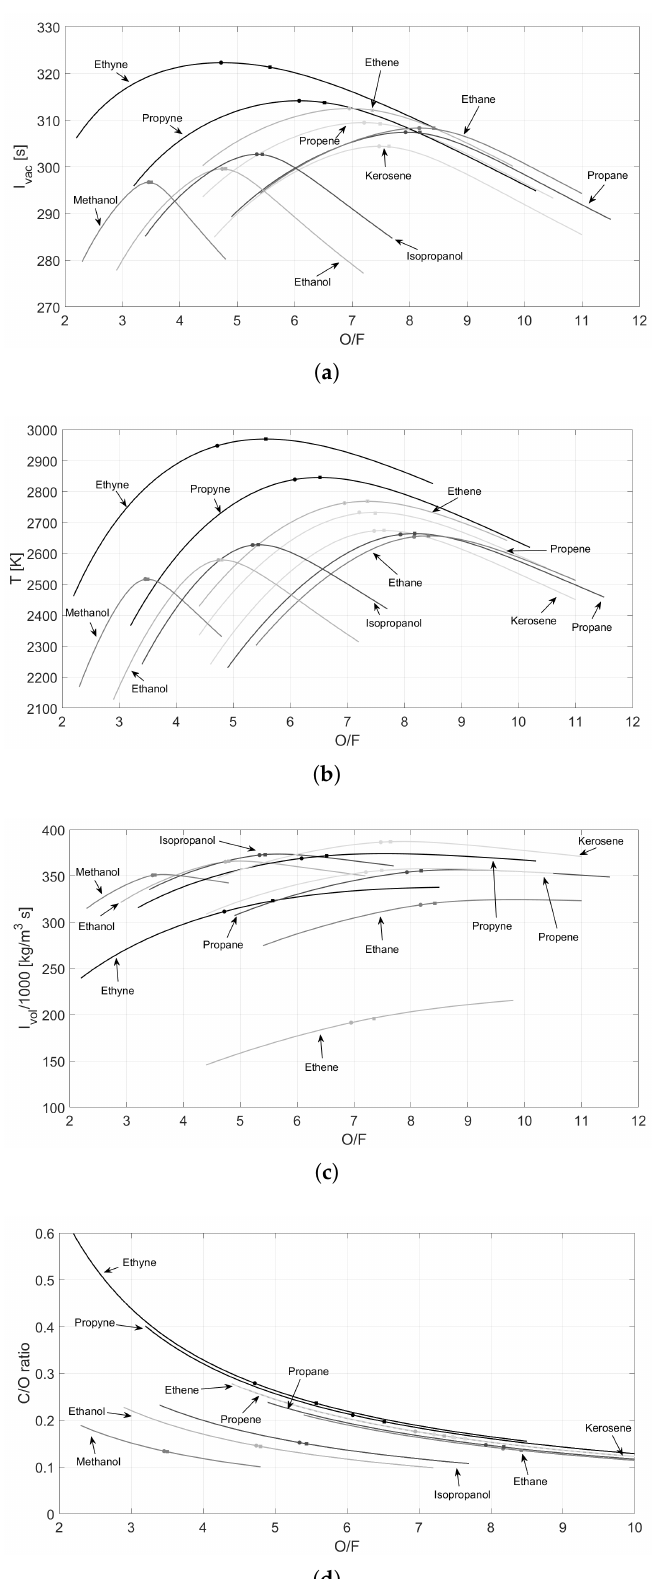
Figure 4. HTP 87.5%-based propellants performances: ( a ) vacuum specific impulse; ( b ) chamber temperature; ( c ) density impulse; and ( d ) C/O